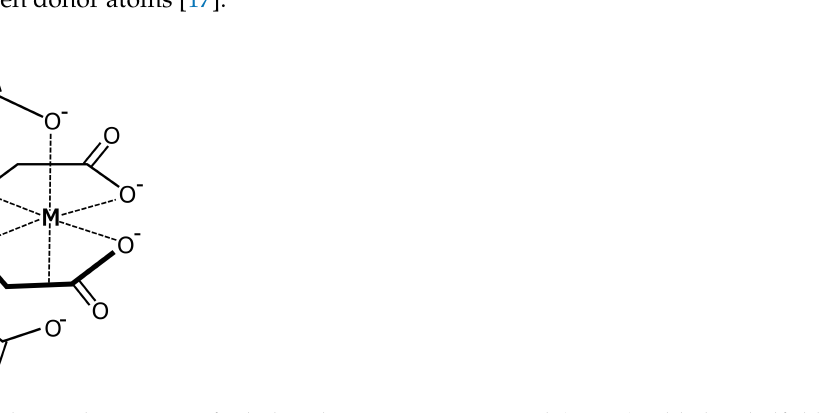
Figure 1. Chemical structure of ethylenediaminetetraacetic acid (EDTA) added to half-diluted Thisted